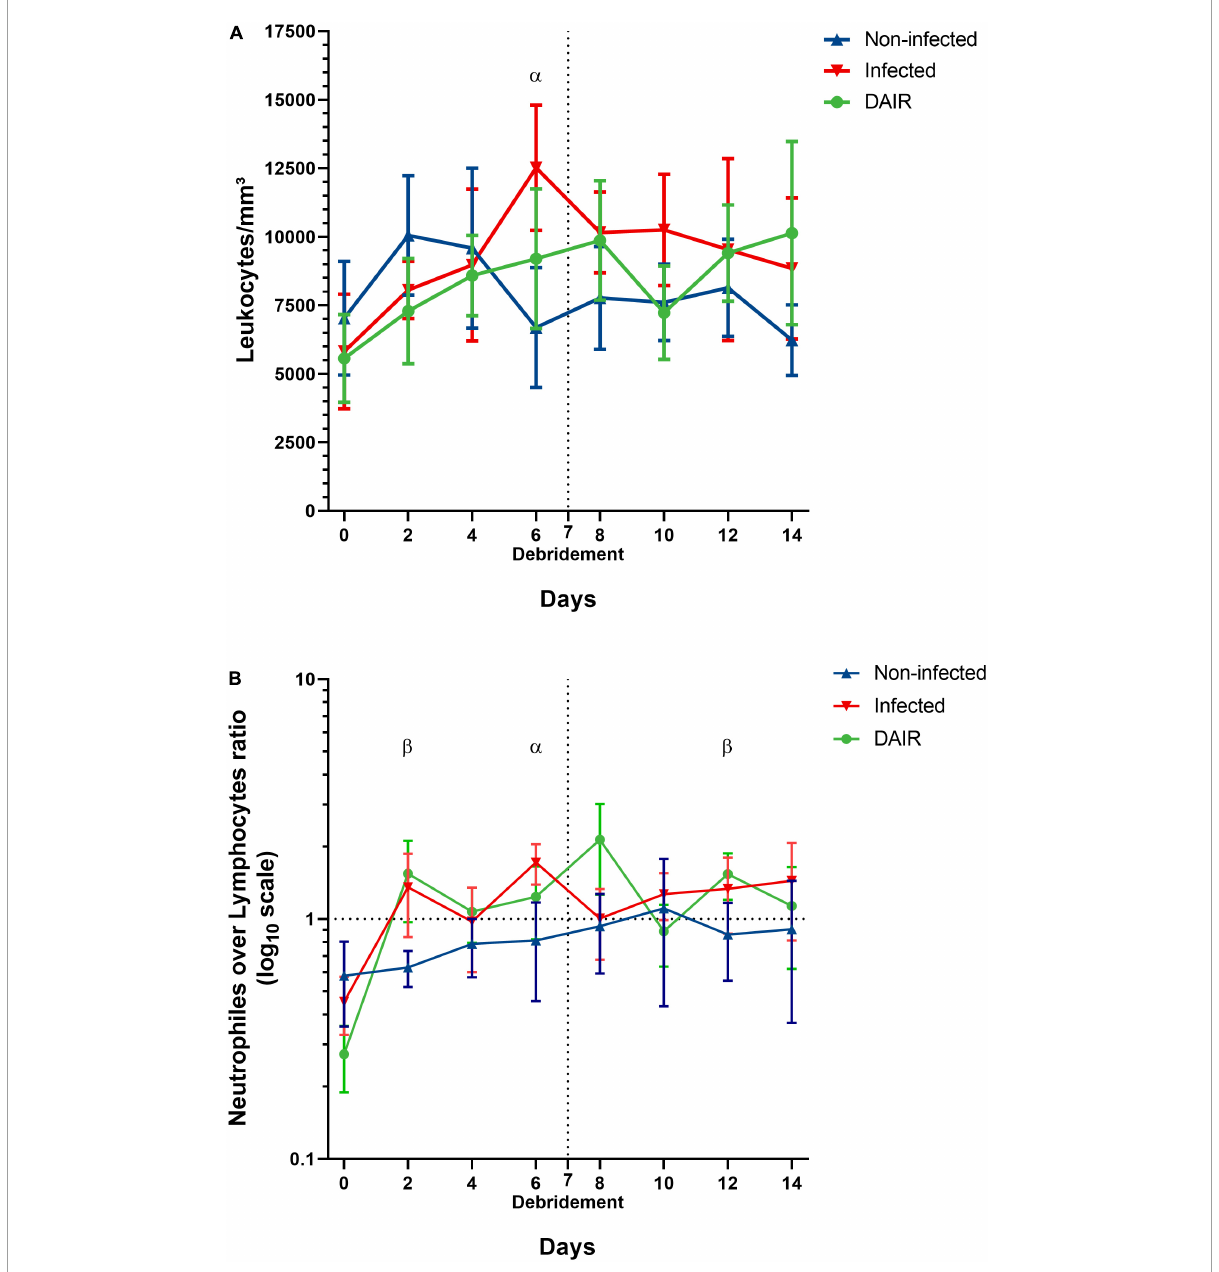
FIGURE6 Post-operative evolution of the total leukocytes counts (A) and neutrophils over lymphocytes ratio expressed in base 10 logarithms (B) , blue: Group A (non-infected animals); red: Group B (infected animals); green: Group C (animals treated with DAIR). Vertical dashed lines indicate the day of debridement surgery. Horizontal dashed lines indicate an N/L ratio of 1. Statistical analysis: two-way repeated-measures ANOVA and Bonferroni post hoc test. α : statistically significant difference between groups A and B; β : statistically significant difference between groups A and C. N =